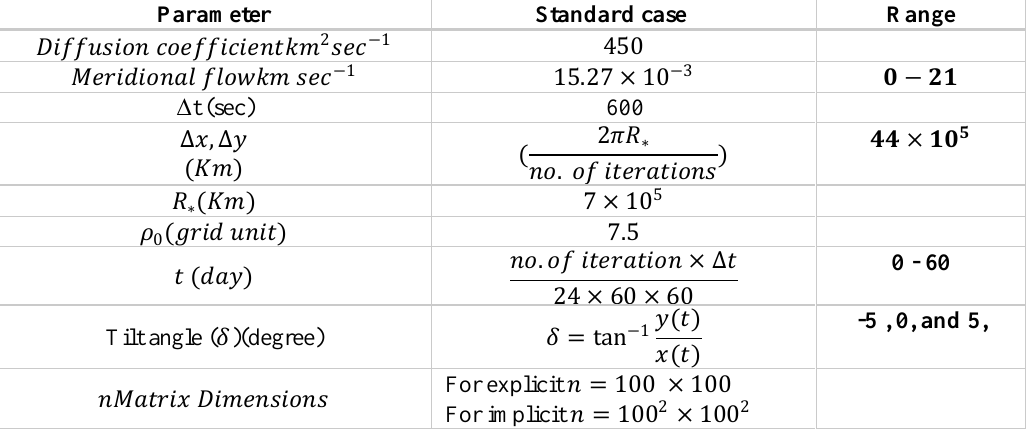
Table 1: Gives an overview of the parameters used in this simulation.